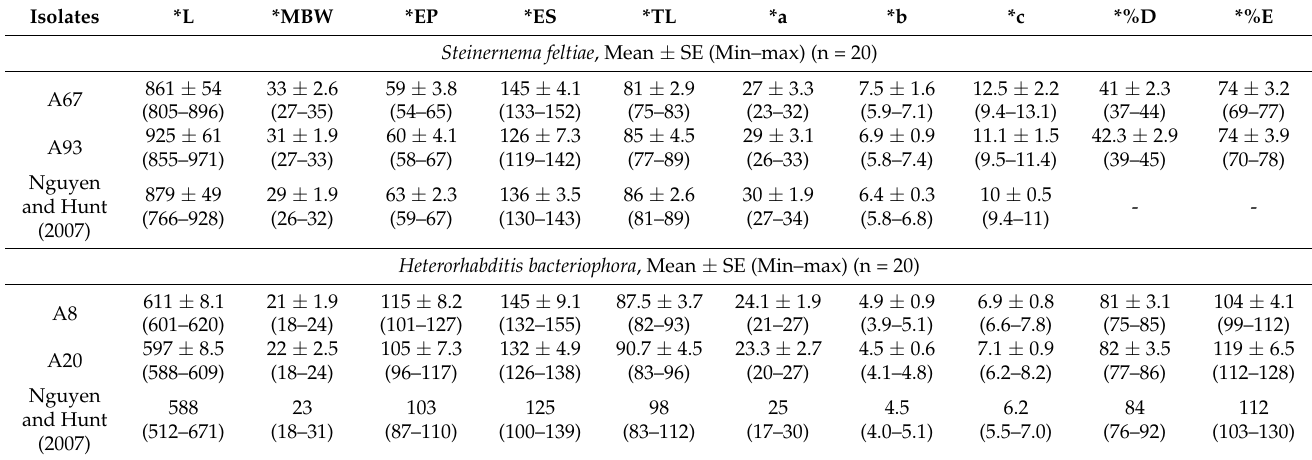
Table 2. Morphometric measurements of infective juveniles (IJs) of some of the isolates of ento- mopathogenic nematode species recovered from survey studies ( µ M).